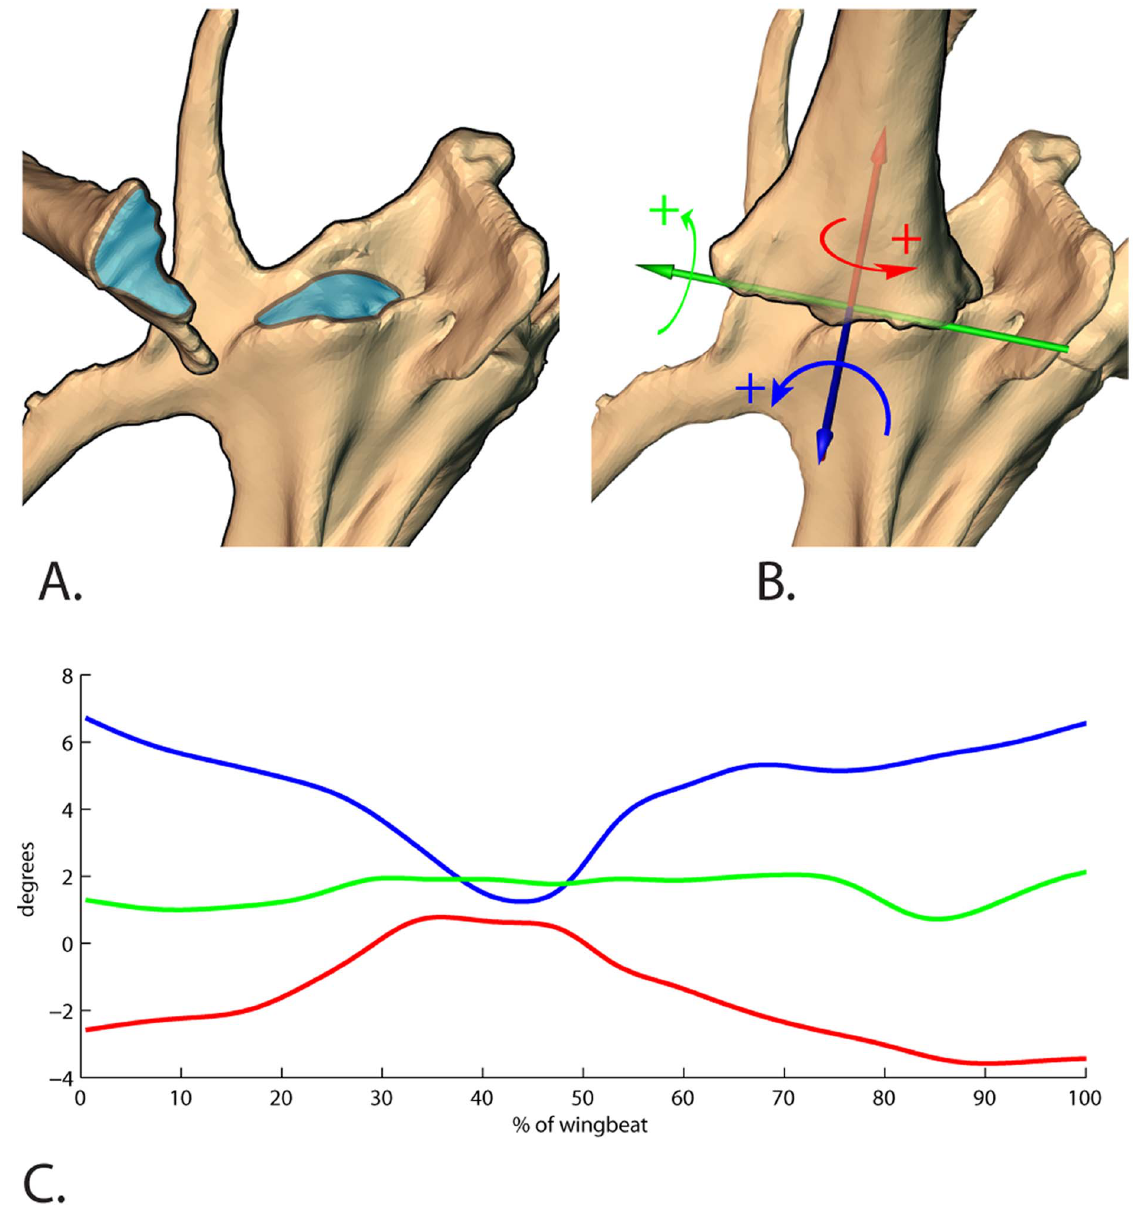
Figure 4. Coracosternal articulation and coordinate system. A. the articular surface (blue) of the proximal coracoid fits into the elongate sulcus (blue) on the anterior end of the sternum. B. the joint coordinate system used to measure coracosternal movements. Blue=abduction/ adduction axis; Green=protraction/retraction; Red=long axis rotation. C. rotation at this joint was primarily found during AF. The majority of movement during downstroke was adduction, causing medial movement of the distal coracoid. Almost no protraction/retraction rotation was indicated, but internal long axis rotation was found in downstroke. However, it should be noted that the amount of rotation in all cases is within the range of error for individual degrees of freedom (Table 3). Our validations show that while the placement of the distal coracoids is highly reliable, the actual movements at the coracosternal joints are less accurate given that measures are compounded from both sternal and coracoid registration during rotoscoping. tion/retraction, and then 3) long axis rotation (blue, green, red; Fig. 4). The blue axis remained fixed to the sternum; the red axis was fixed to the coracoid and the green axis ‘‘floats’’ to stay perpendicular to both [32].